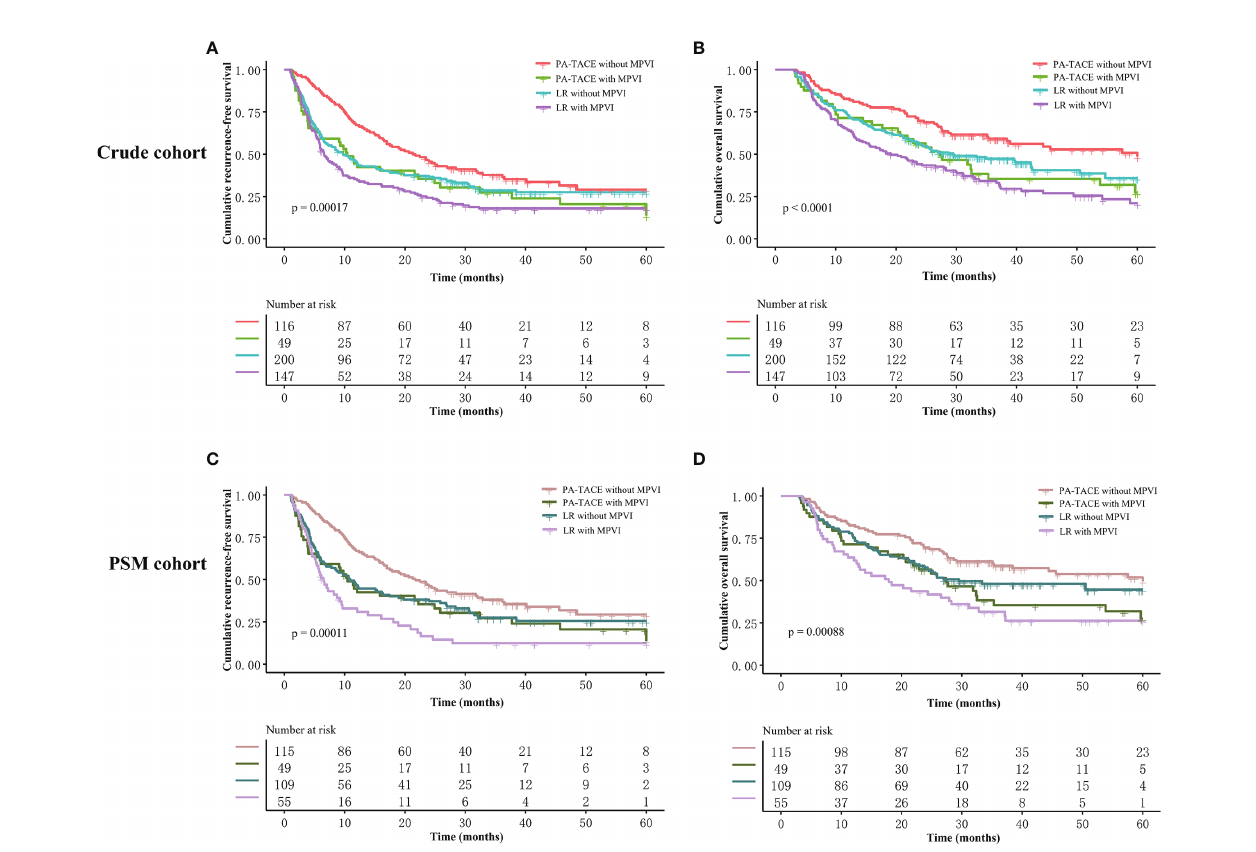
FIGURE 4 | Kaplan – Meier analysis of RFS and OS strati fi ed by all subgroups before and after PSM. (A) RFS strati fi ed by treatment and MPVI presence in crude cohort. (B) OS strati fi ed by treatment and MPVI presence in crude cohort. (C) RFS strati fi ed by treatment and MPVI presence in PSM cohort. (D) OS strati fi ed by treatment and MPVI presence in PSM